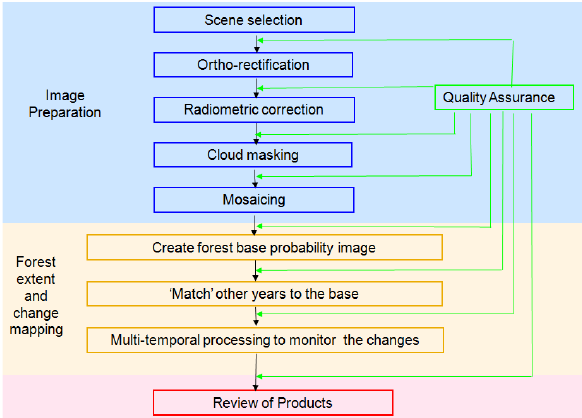
Figure 3. Flowchart of the steps in the annual forest monitoring processing